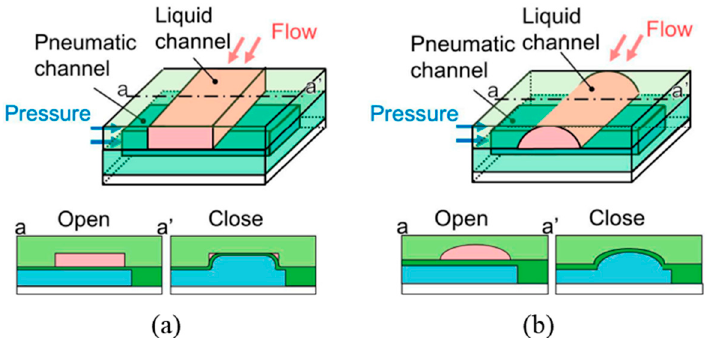
Figure 11. Cross sections of microchannels in pneumatic pressure-driven microvalves [84]: ( a ) Rectangular cross section; ( b ) Semicircular cross